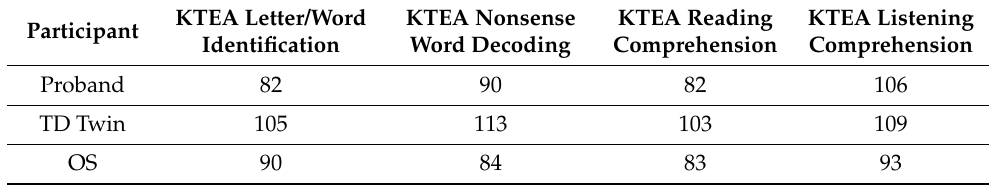
Table 2. Sibling behavioral data.